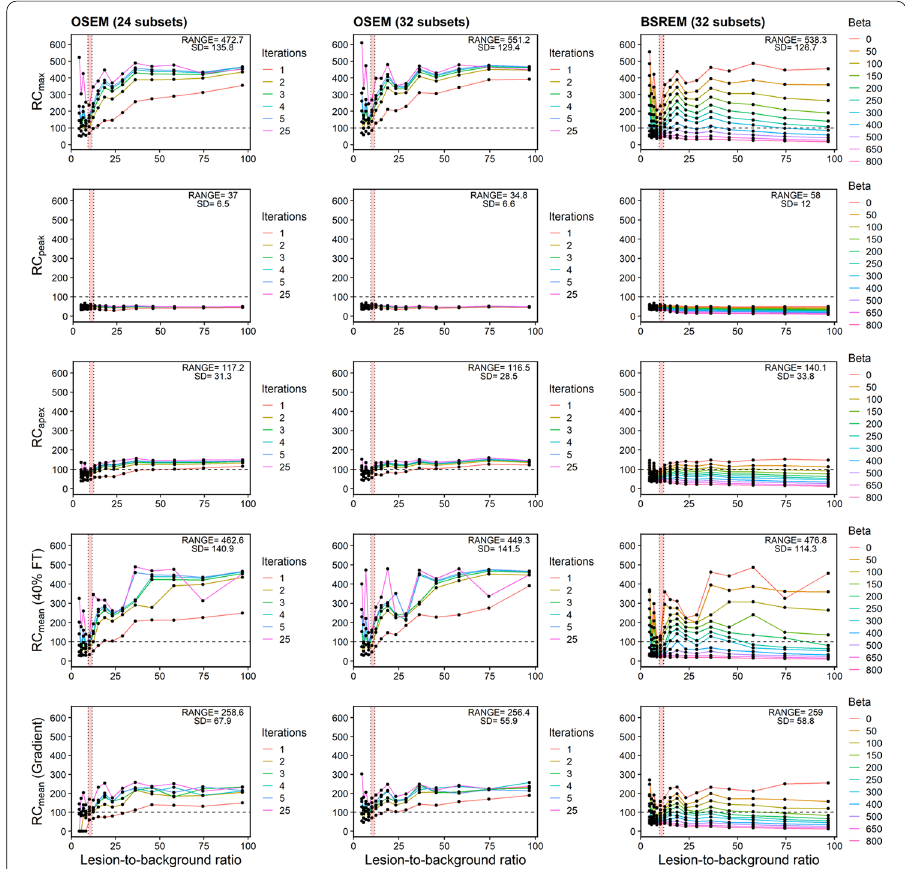
Fig. 7 Robustness of recovery curves. Recovery concentration coefficient versus lesion-to-background ratio for 10-mm lesion measured in Probe-IQ pelvis. (Top to bottom) Max, Peak, Apex, and Mean (40% FT and gradient). (Left to right) Reconstruction algorithms using OSEM PSF (24 and 32 subsets, respectively) and + BSREM. Range and standard deviation of recovery coefficients annotated on plots. [ 18 F]DCFPyL background activity levels are represented by red shaded